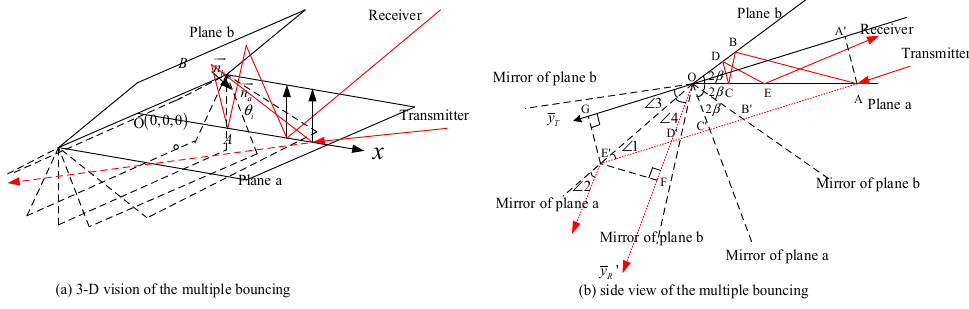
Figure 4. Three-bouncing reflection path of an acute dihedral corner case.